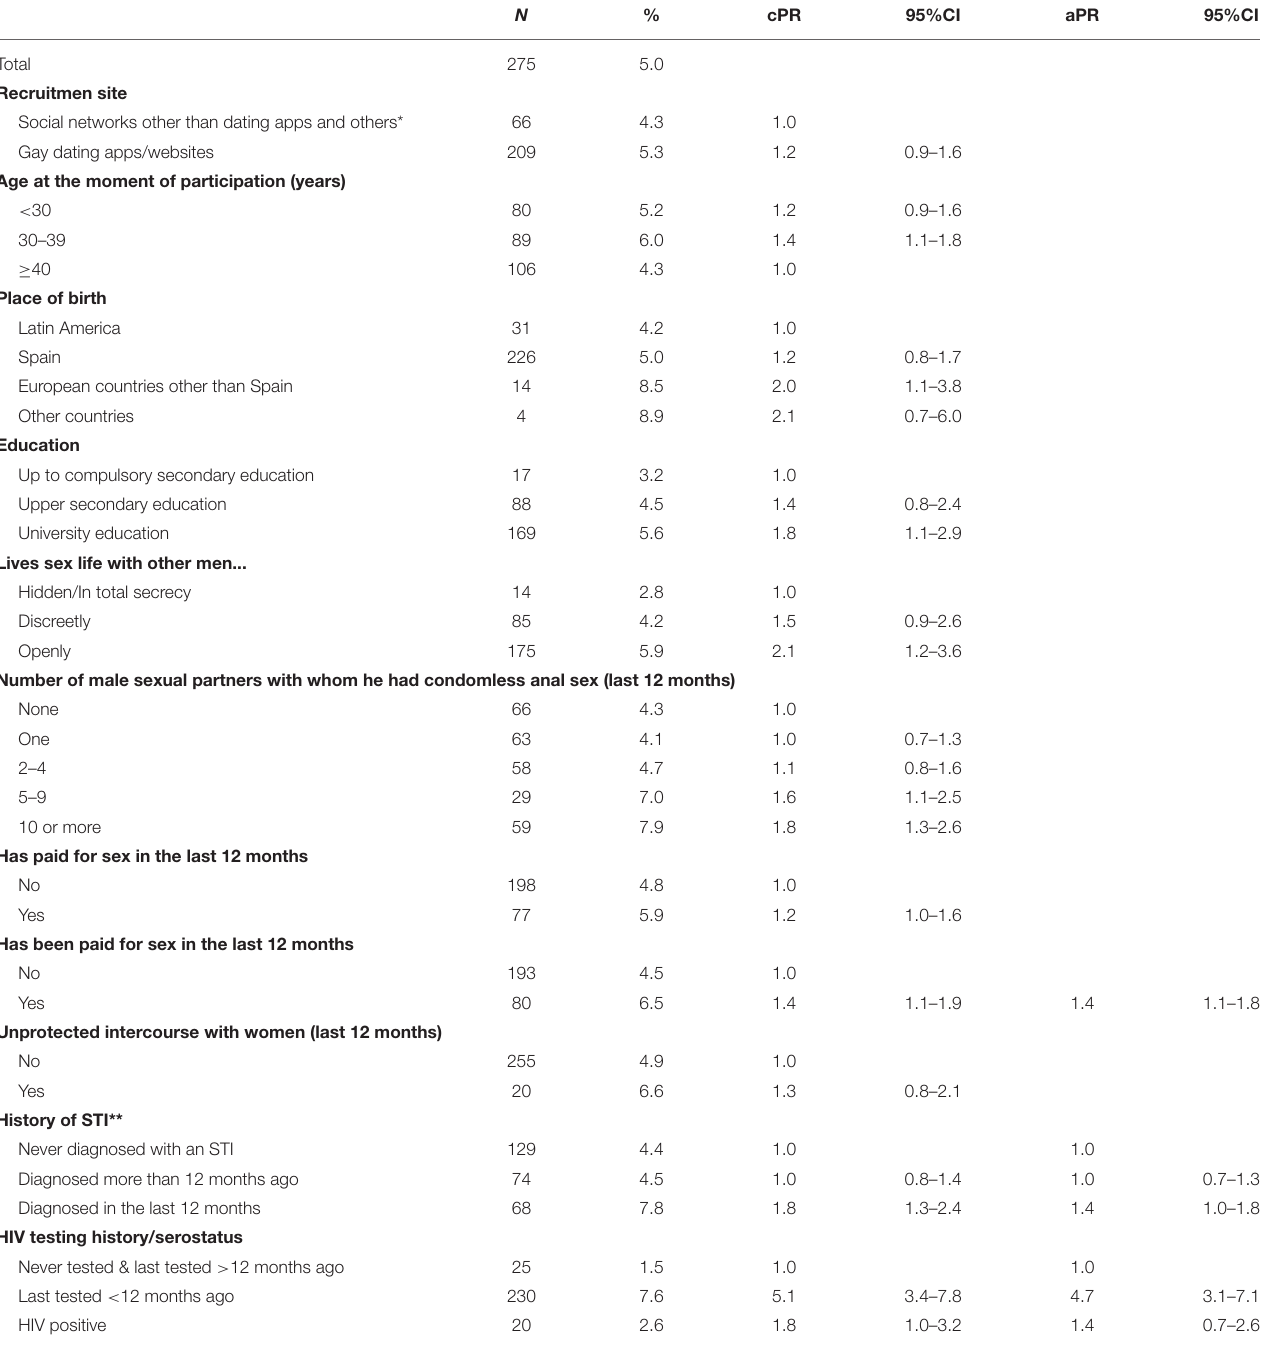
TABLE 3 | Proportion of participants who had used a self-testing kit in the past and associated factors ( N = 5,488). N %